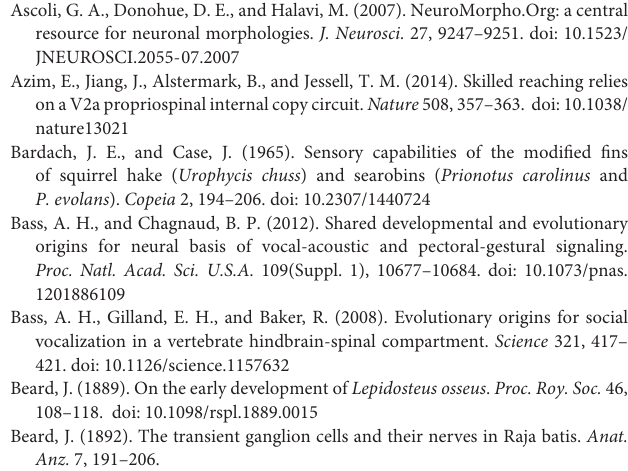
Supplementary Figure 1 | (A) A subset of HB FSNs exhibit a variety of innervation patterns on the axial surface. In some cases there is very little axial innervation, and in other cases there is extensive innervation in the immediate area of the fin. Cells are numbered according to putative clusters, but the grouping are small and unstable. (B) Cluster dendrogram and cluster plot (below) for the whole cell reconstructions in (A) . (C) Box plots of each of the 10 morphological parameters, together with two soma parameters, utilized in the cluster analysis. Boxes are color coded in accordance with cluster number. Black point overlays indicate the individual values for each neuron. Anterior is to the left and dorsal is up in (A) . Supplementary Table 1 | The minimum value, maximum value, mean, median, standard deviation, and p -value from Shapiro-Wilk Normality test of the 11 morphological parameters. P -values greater than 0.05 indicate normalcy, and the final column has a ∗ to highlight normally distributed parameters. Supplementary Table 2 | Full description of the morphological parameters. Supplementary Table 3 | Cell ID and cluster assignment number associated with soma position for plotting the x -axis in Figure 5 . Supplementary Movie 1 | A 3D volume reconstruction of a single FSN exhibits the extensive innervation of the fin as well as the path of innervation along the surface of the skin. Anterior is to the right at the start of the movie, dorsal is up. The reconstruction rotates 180 degree along the anteroposterior